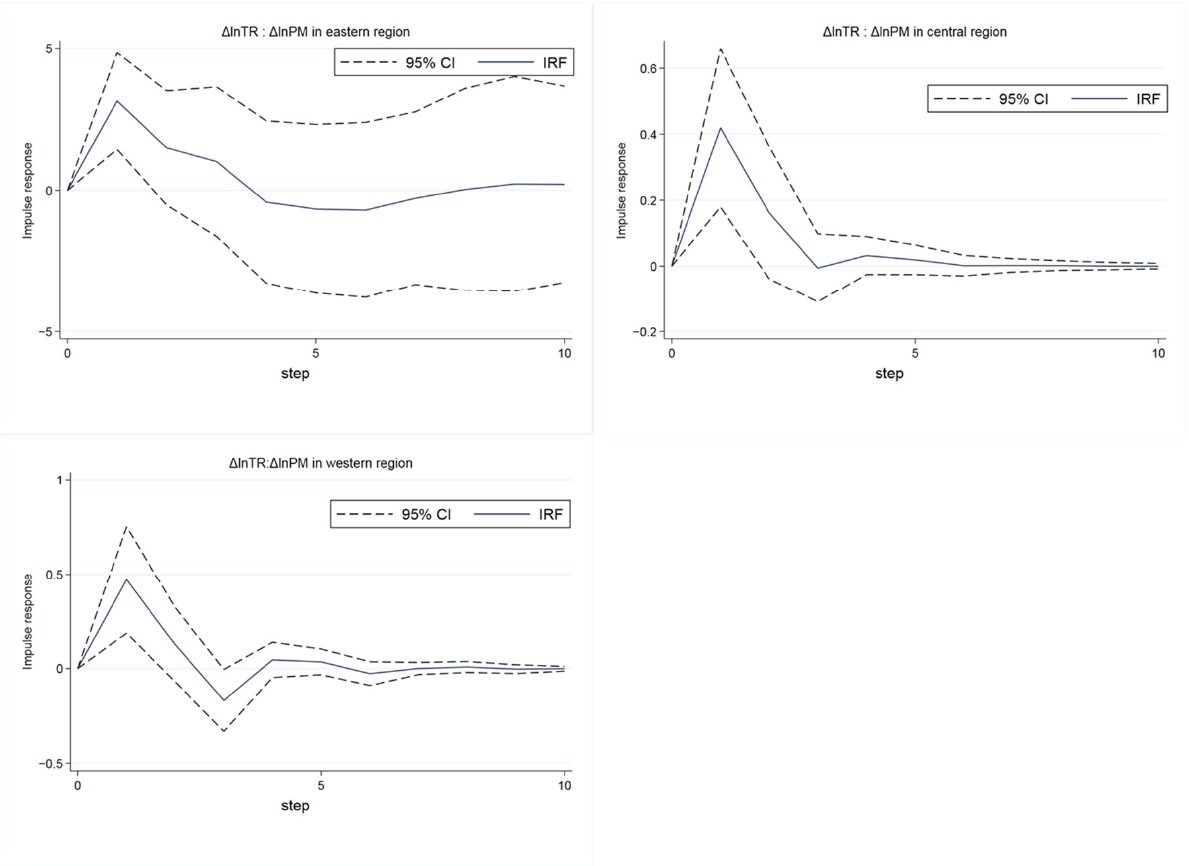
Figure 5. The results of impulse response in east/central/west region.